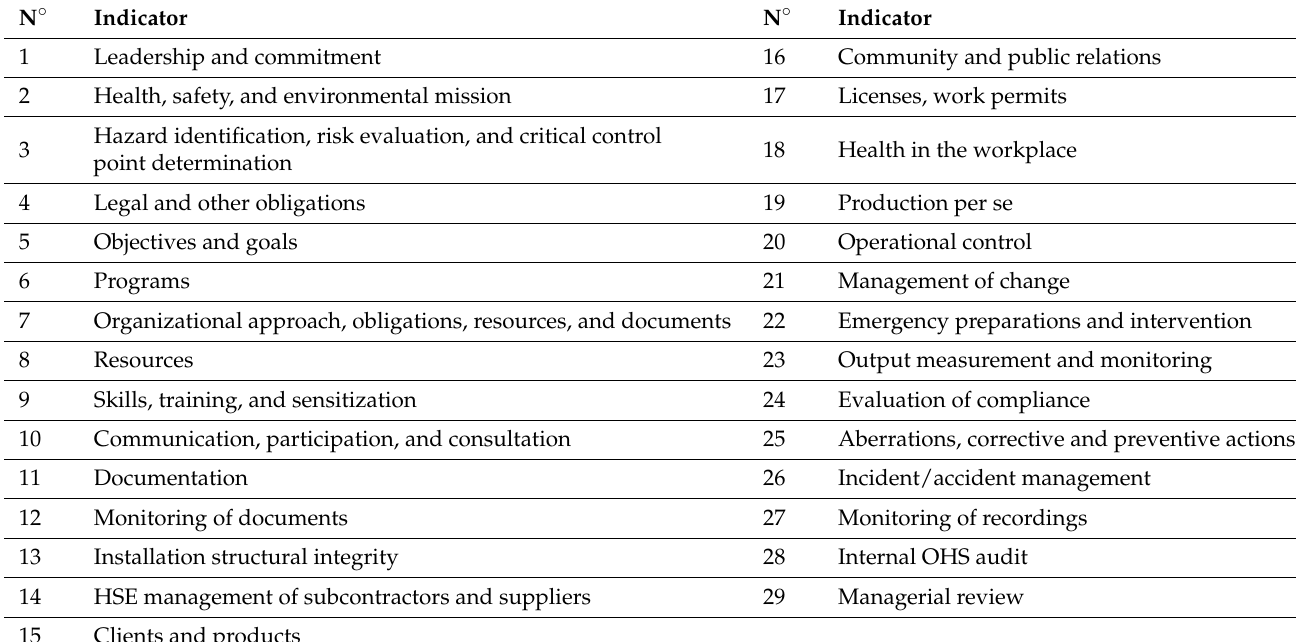
Table 9. The 29 indicators in the HSE tool